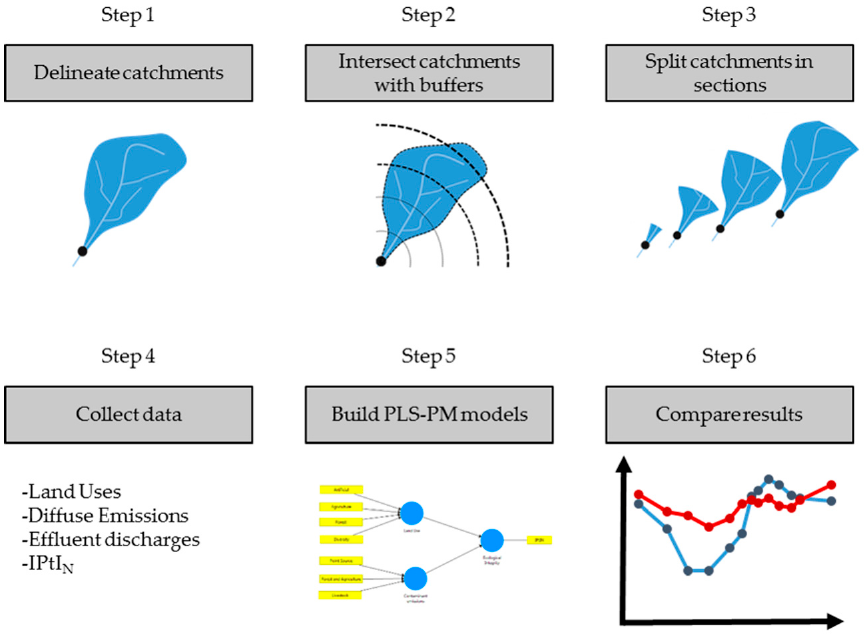
Figure 2. Workflow distributed in six steps.